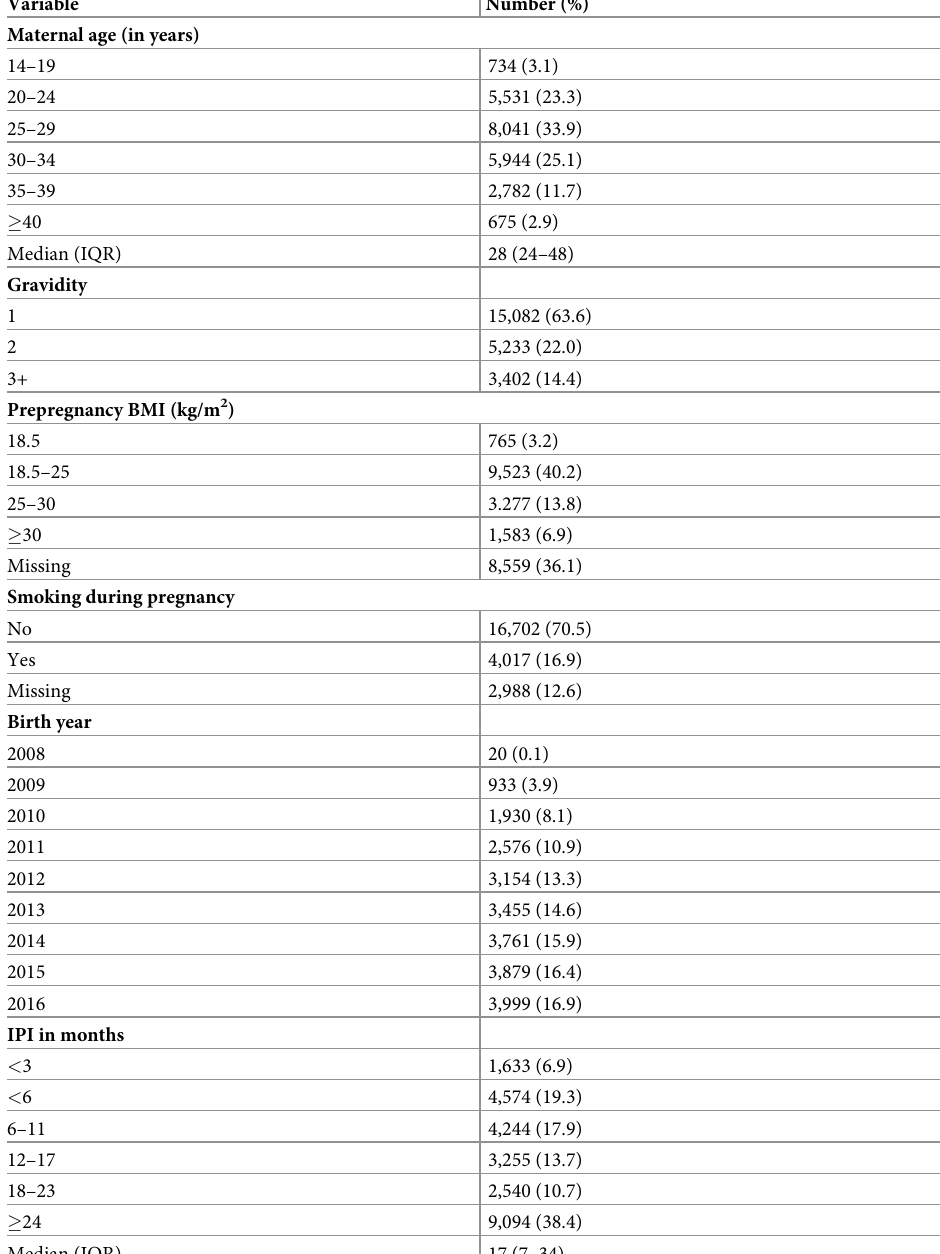
Table 2. Characteristics for women with births after induced abortion at the time of birth after the IPI for births between 2008 and 2016 in Norway ( n = 23,707).